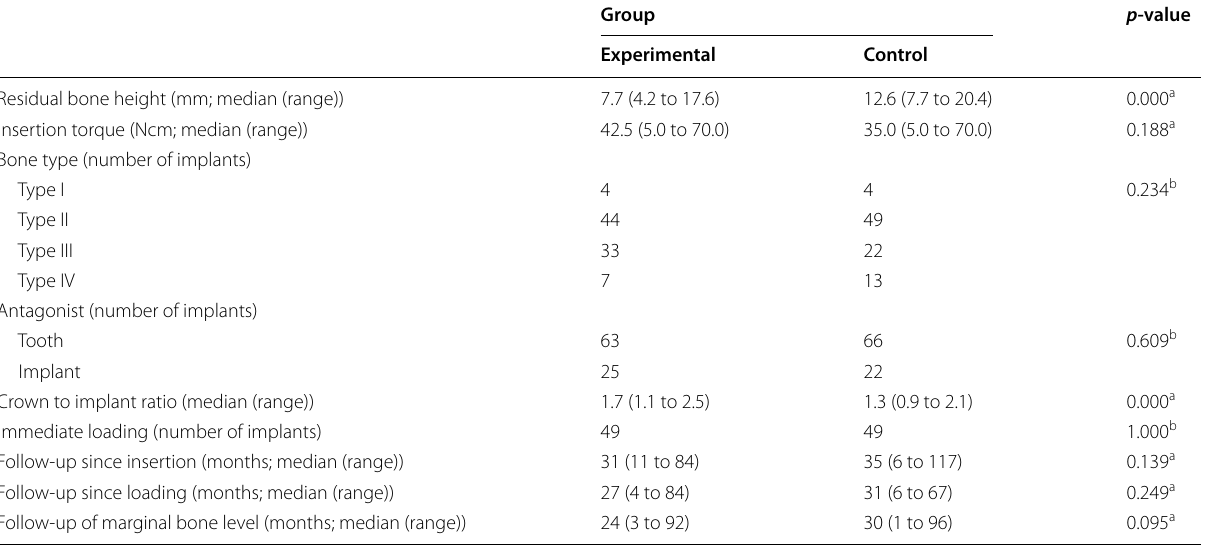
Table 2 Surgical data, crown-to-implant ratio, and follow-up